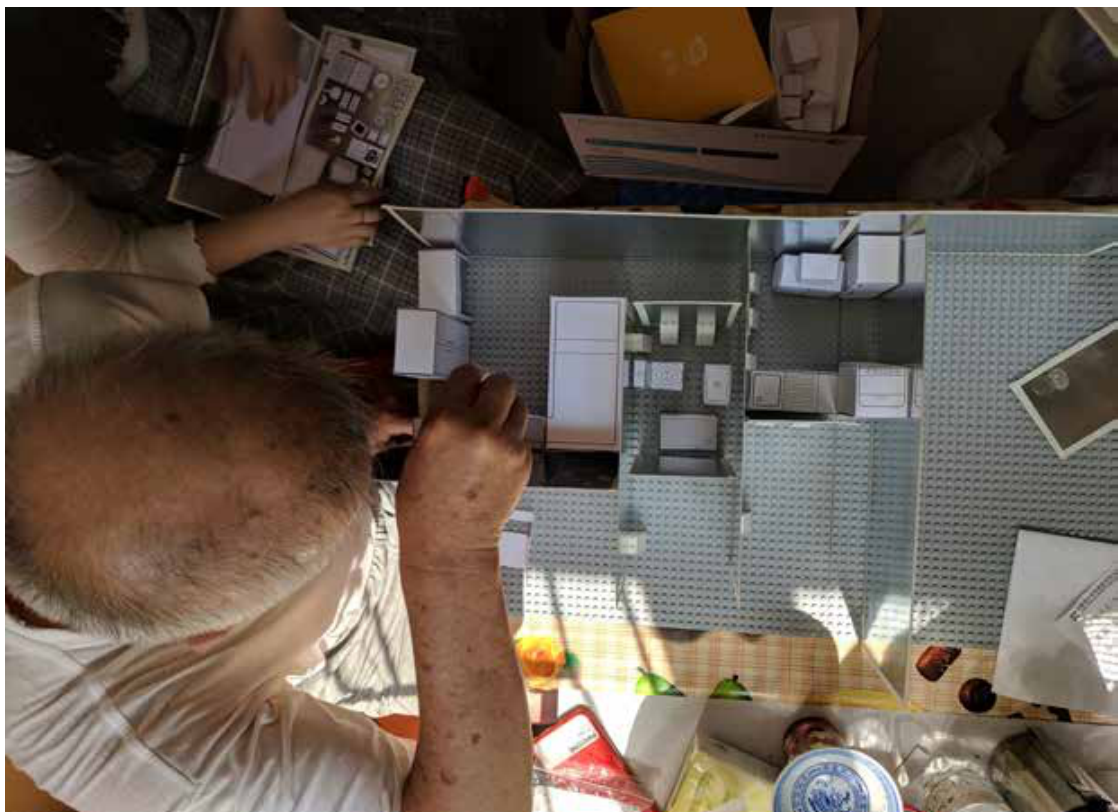
Figure 7 (page 69): Searching design patterns, or meaningful visual structure, is a significant learning experience and creative outcome of prototyping. This image is the result of a group of secondary school students after they explored PET bottles’ material properties through trial and error, and explored pattern recognition by organising the material.